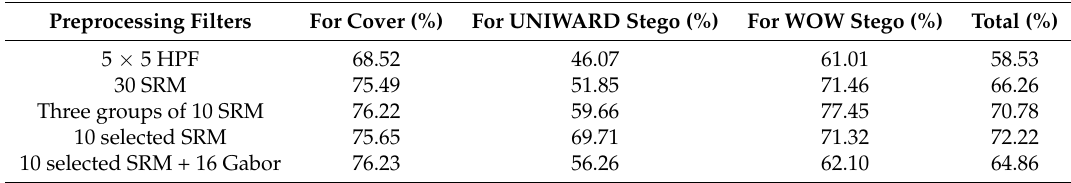
Table 9. Ternary classification rates of the network of Figure 11a with different preprocessing filters ( bpp = 0.4).